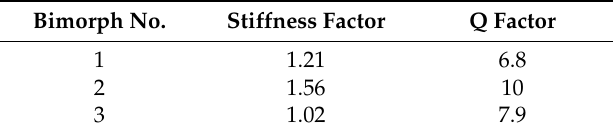
Table 3. Three bimorphs system-stiffness and Q factors. Bimorph